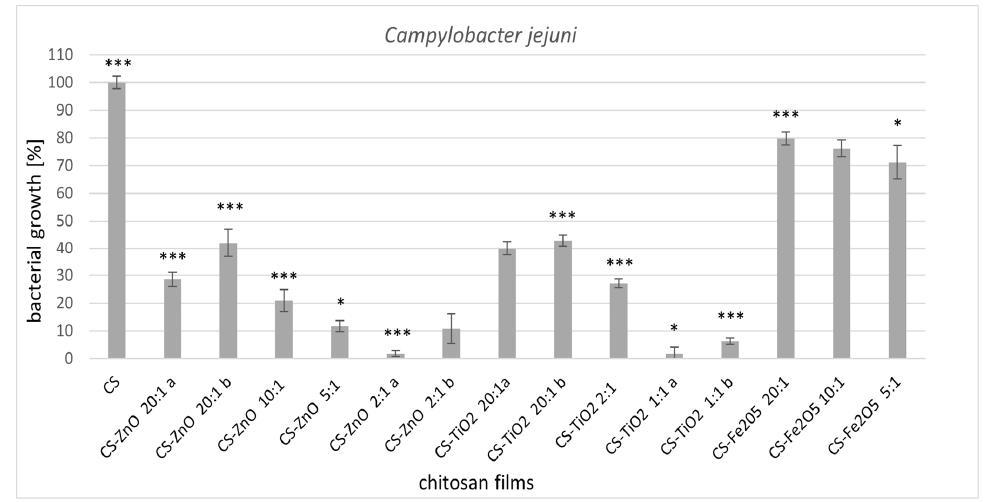
Figure 2. Reduction of Campylobacter jejuni ATCC 33560 with treatments with metal-oxide chitosan films after 24 h incubation. The value from control group (CS) was set as 100%. Statistical significance is marked in relation to the chitosan nanocomposite (CS) ( n = 6, * p < 0.05, *** p < 0.001).